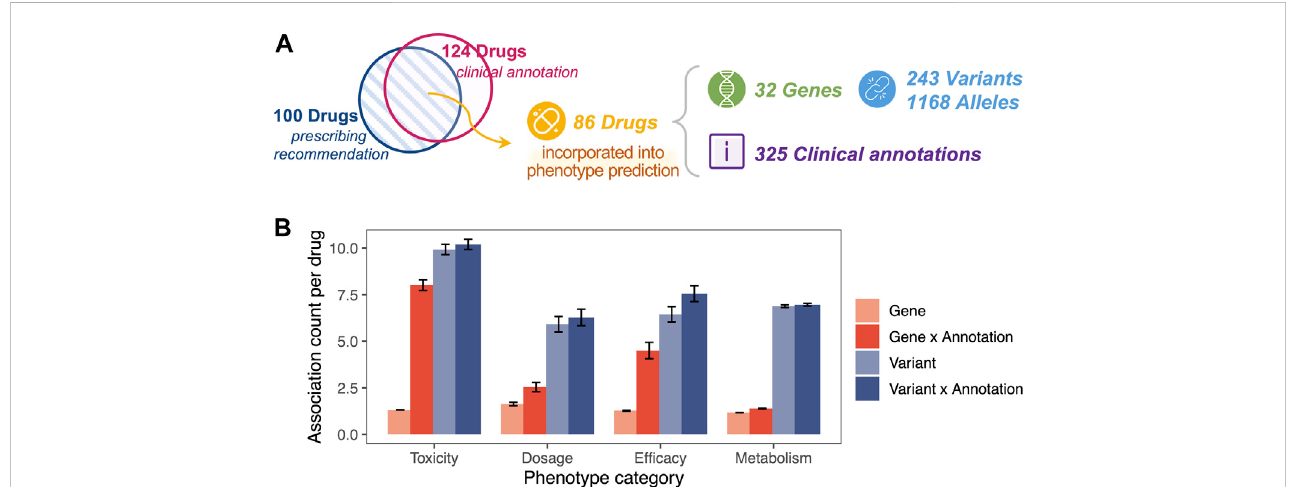
FIGURE 3 One-to-many clinical association for a given drug. (A) The PharmGKB clinical annotations used by PAnno covered 86 drugs, 32 genes, 243 variants, and 1168 alleles. The blue circle represents drugs covered in the prescribing recommendations of CPIC, DPWG, CPNDS, and RNPGx guidelines. The pink circle representeddrugs involvedinclinicalannotationswithevidencelevels of1A,1B,2A,and2BinPharmGKB. (B) Averagenumberofassociations for agivendrug inrelationto genes(lightred),combinations ofgenesandannotations (darkred),variants(light blue),andcombinations ofvariantsand annotations(dark blue). Error bars represent ±standard error of mean. The x-axis indicates the different phenotype categories, including toxicity, dosage, ef fi cacy, and